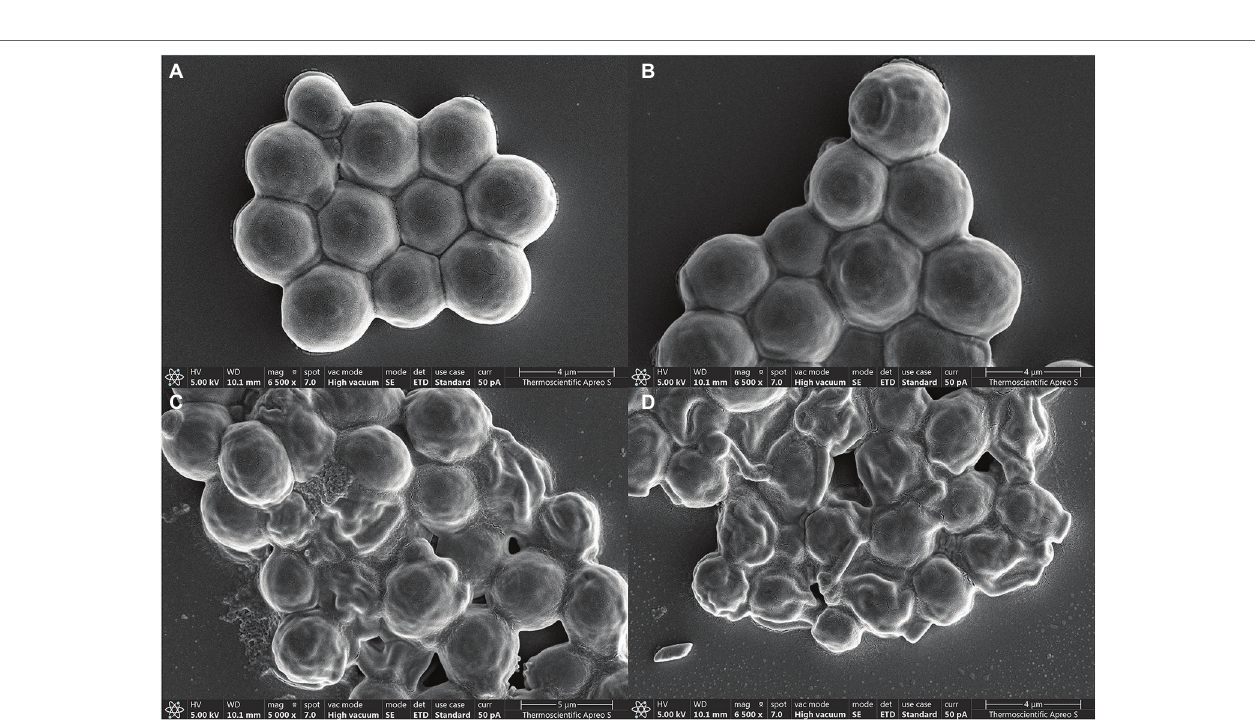
FIGURE 8 | Electron microscopy of Candida albicans . (A) Typical structure of yeast cells under normal condition. Structural change was observed after incubation with 64 μ g/ml (B) , 128 μ g/ml (C) , and 256 μ g/ml (D) of β